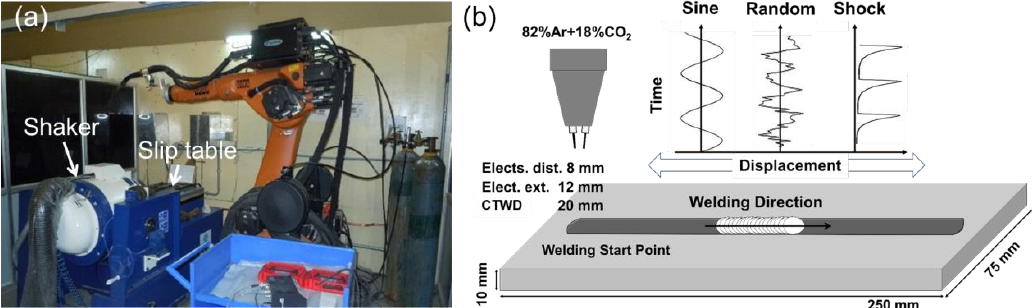
Figure 1. ( a ) A robotic welding instrument and ( b ) a welding set-up used in a vibration assisted welding.